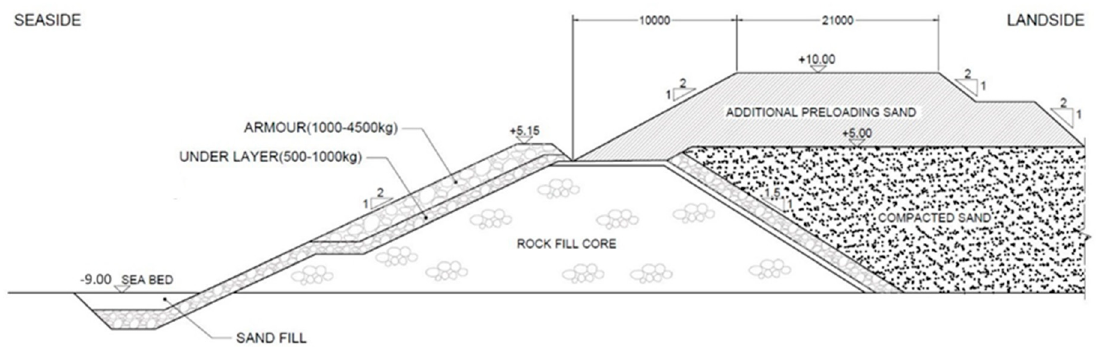
Figure 3. Typical cross-section in the outer revetment during preloading with fill embankment.